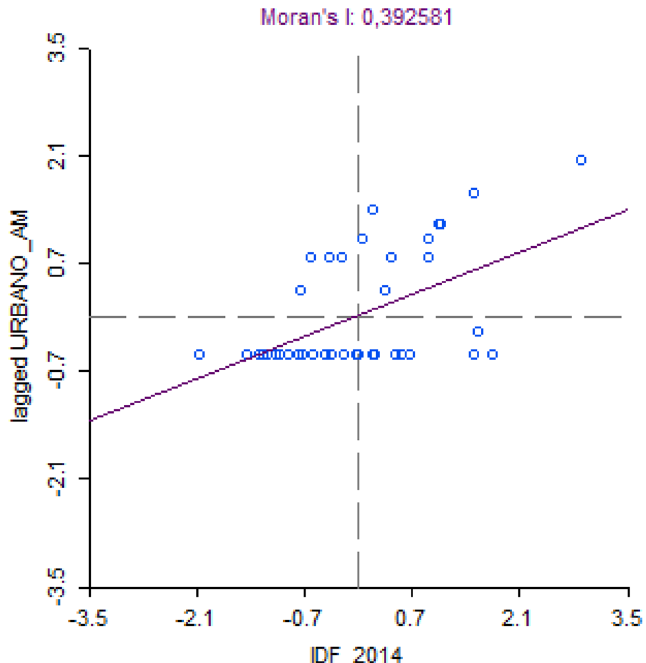
Fig. 4 Global Moran Index for the fiscal efficiency (IDF_2014) and the categorization of the area (by metropolitan area). Source: own computation based upon GeoDa